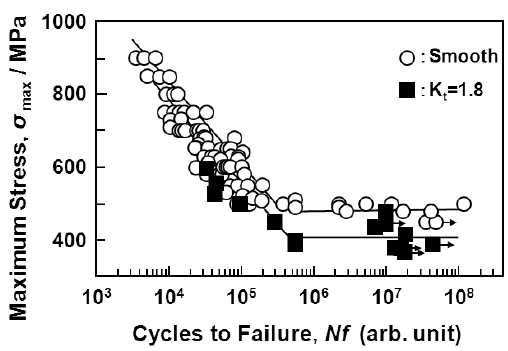
Figure 10. Effect of notch on S-N curves obtained by tension-to-tension fatigue test with sine wave (10 Hz) for annealed Ti-15Zr-4Nb-4Ta alloy plates.